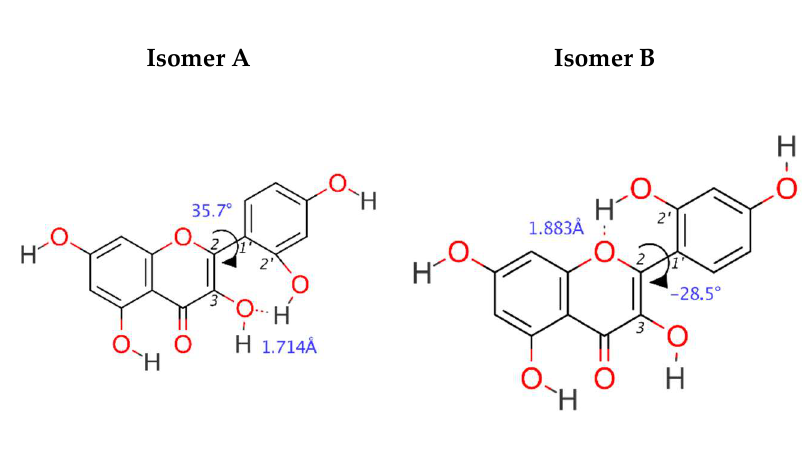
Figure 2. Comparison in geometry between morin’s A and B isomer.